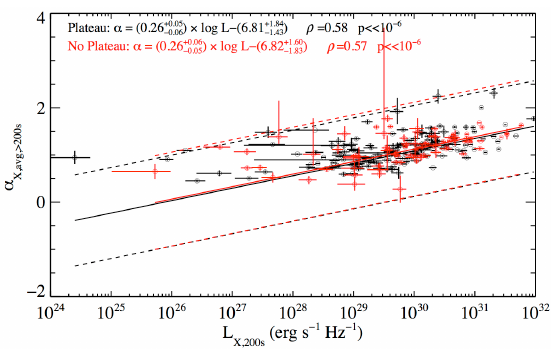
Figure 2. Luminosity–decay correlation using the final sample of X-ray light curves split into those light curves that contain a plateau in their best fit (power-law) models and those that do not. The best fit regression parameters and their 1 σ errors, and the Spearman rank coefficient, ρ , and associated probability, p , are given in each panel. The solid line indicates the best fit regression, and the dashed lines indicate the 2 σ deviation (Reproduction of Figure 6 from